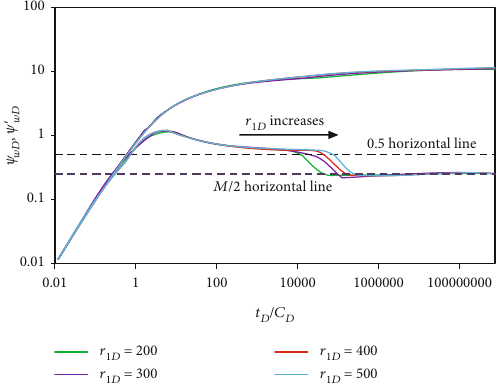
Figure 15: Well test curves of the pressure buildup well test under di ff erent inner zone